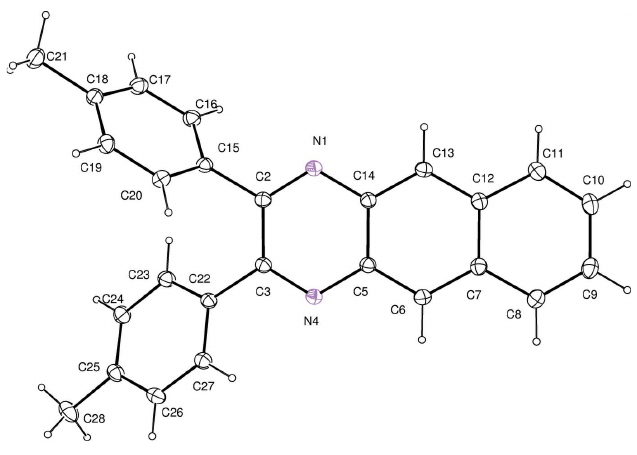
Figure 1 Molecular structure of the title compound, showing the atom-numbering scheme and 30% probability ellipsoids for non-H